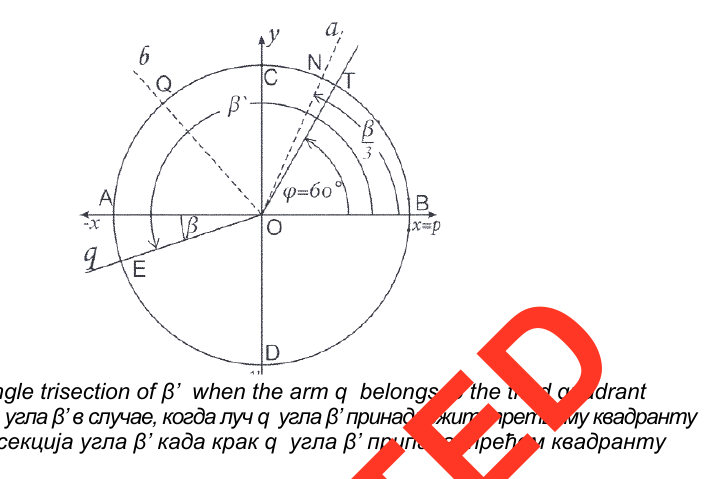
Figure 17 – Angle trisection of β ’ when the arm q belongs to the third quadrant Рис . 17 – Трисекция угла β ’ в случае , когда луч q угла β ’ принадлежит третьему квадранту Слика 17 – Трисекција угла β ’ када крак q угла β ’ припада трећем квадранту The angle BOE is divided into three equal parts by the dashed lines a and b (in Fig. 17). The circular arc TN in Fig. 17 equals the circular arc AL in Fig.16.